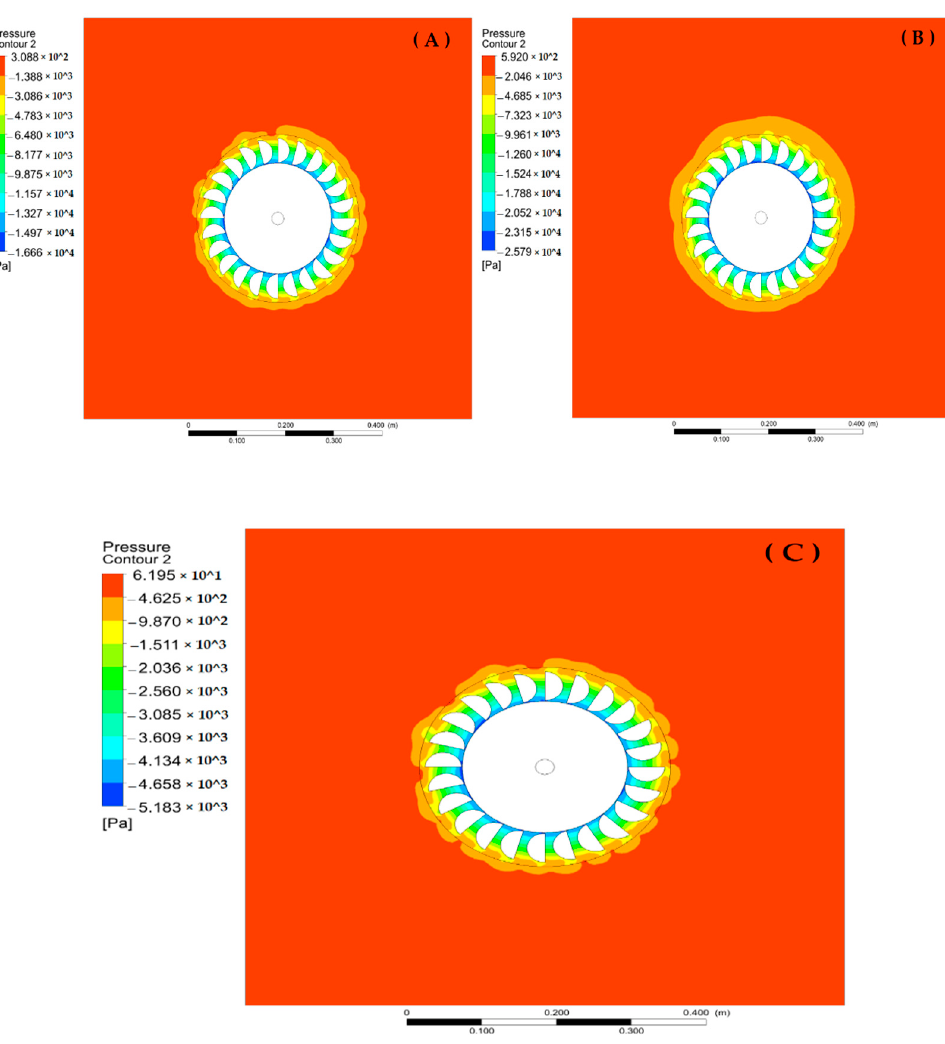
Figure 11. Pressure contours ( A ) rotational speed at 24 rad/s, ( B ) rotational speed at 44 rad/s and ( C ) rotational speed at 54 rad/s.